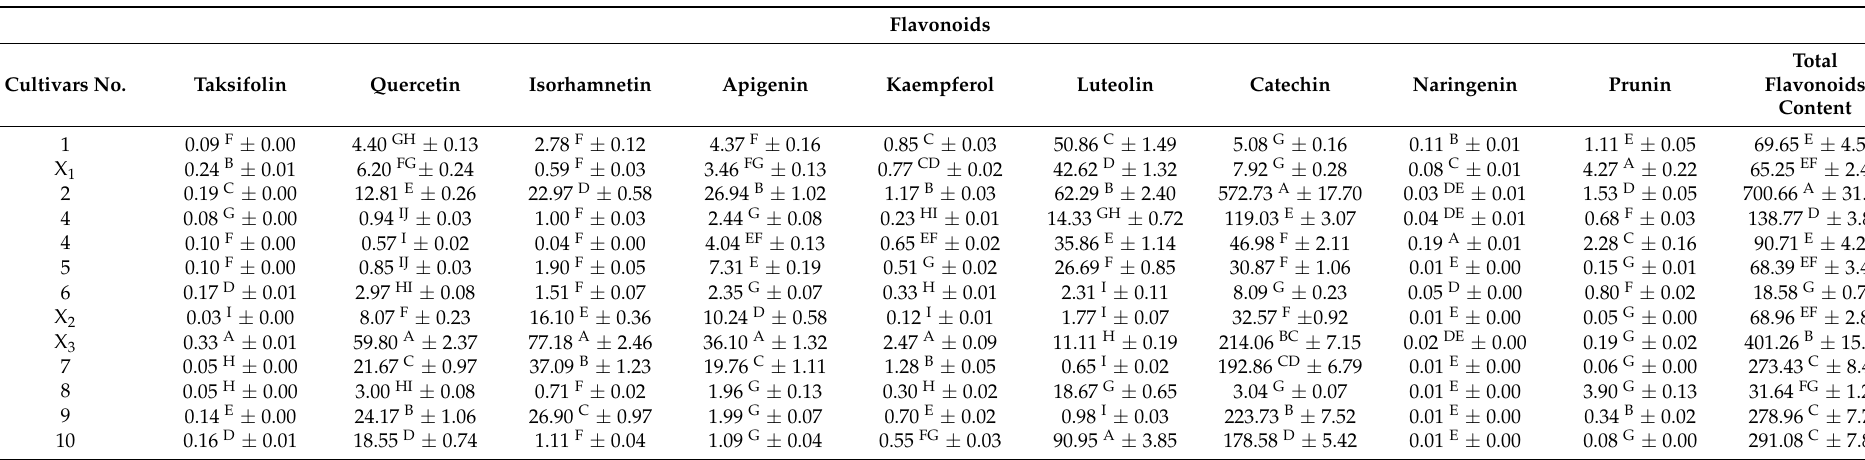
Table 2. The flavonoid content in young stems of selected willow varieties and cultivars from the Czempi´n plantation in the third 10-day period of May 2017 ( µ g/g DM). The mean values from three replicates were supplemented with a standard deviation. The numbers of cultivars as in Table 1.